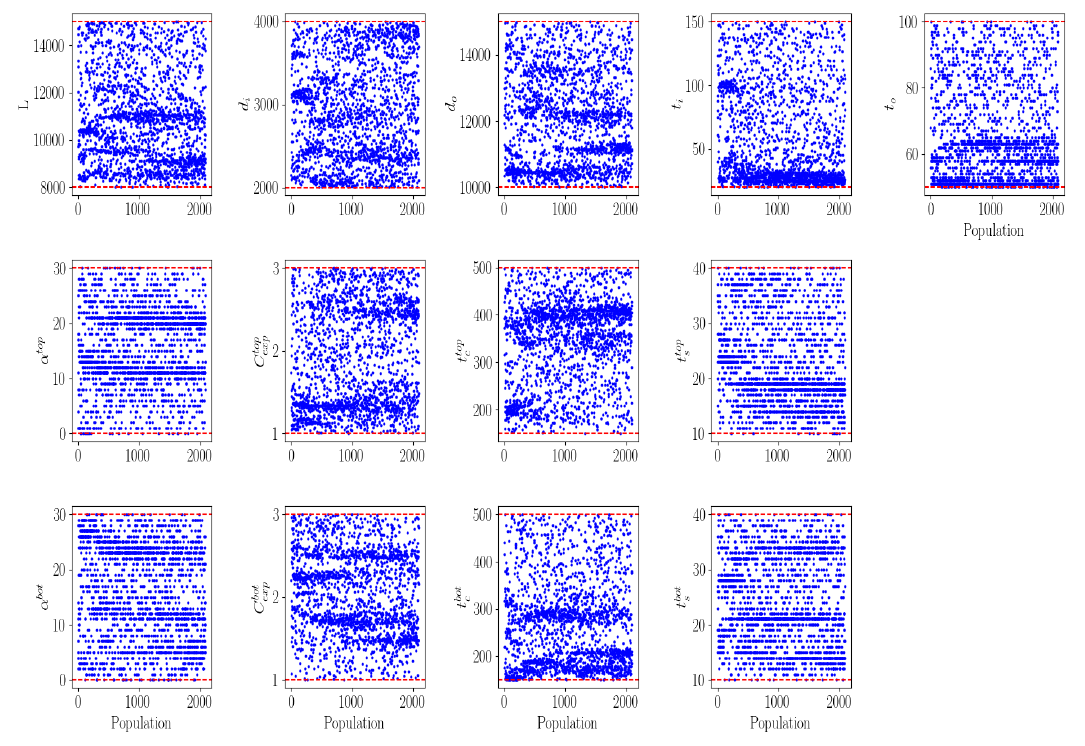
Figure 13. Population’s design variables scatter distribution using the CMNGA and the results shown in Section 4.2. Boundaries of the design space are represented in red dashed